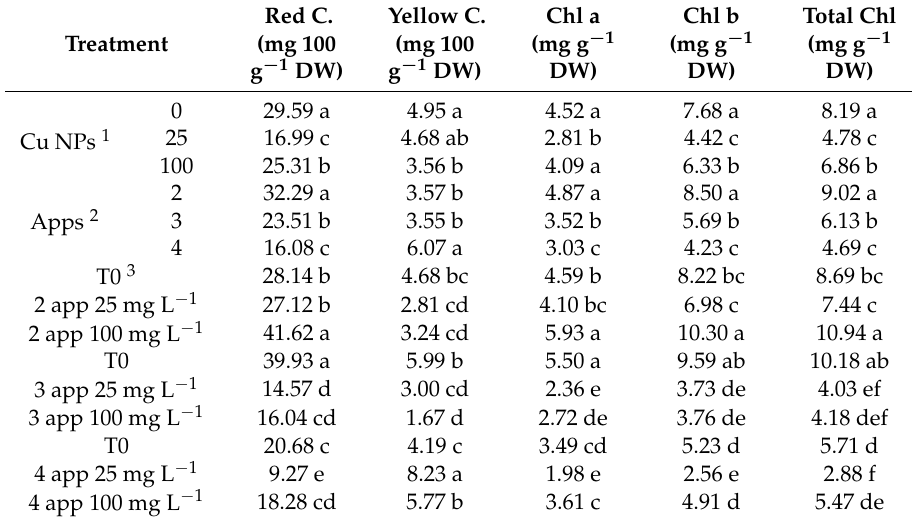
Table 4. Content of carotenoids and chlorophyll in fruits of Moringa oleifera .